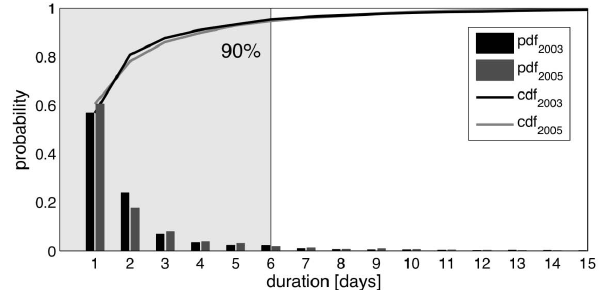
Fig. 6. The empirical probability density function (bar) and cumu- lative density function (line) of continuous melting periods per sea- son observed over Antarctica (not the total per-pixel seasonal dif- ference) for the 2003–2004 and 2005–2006 season that are found using a FT3 but rejected in by